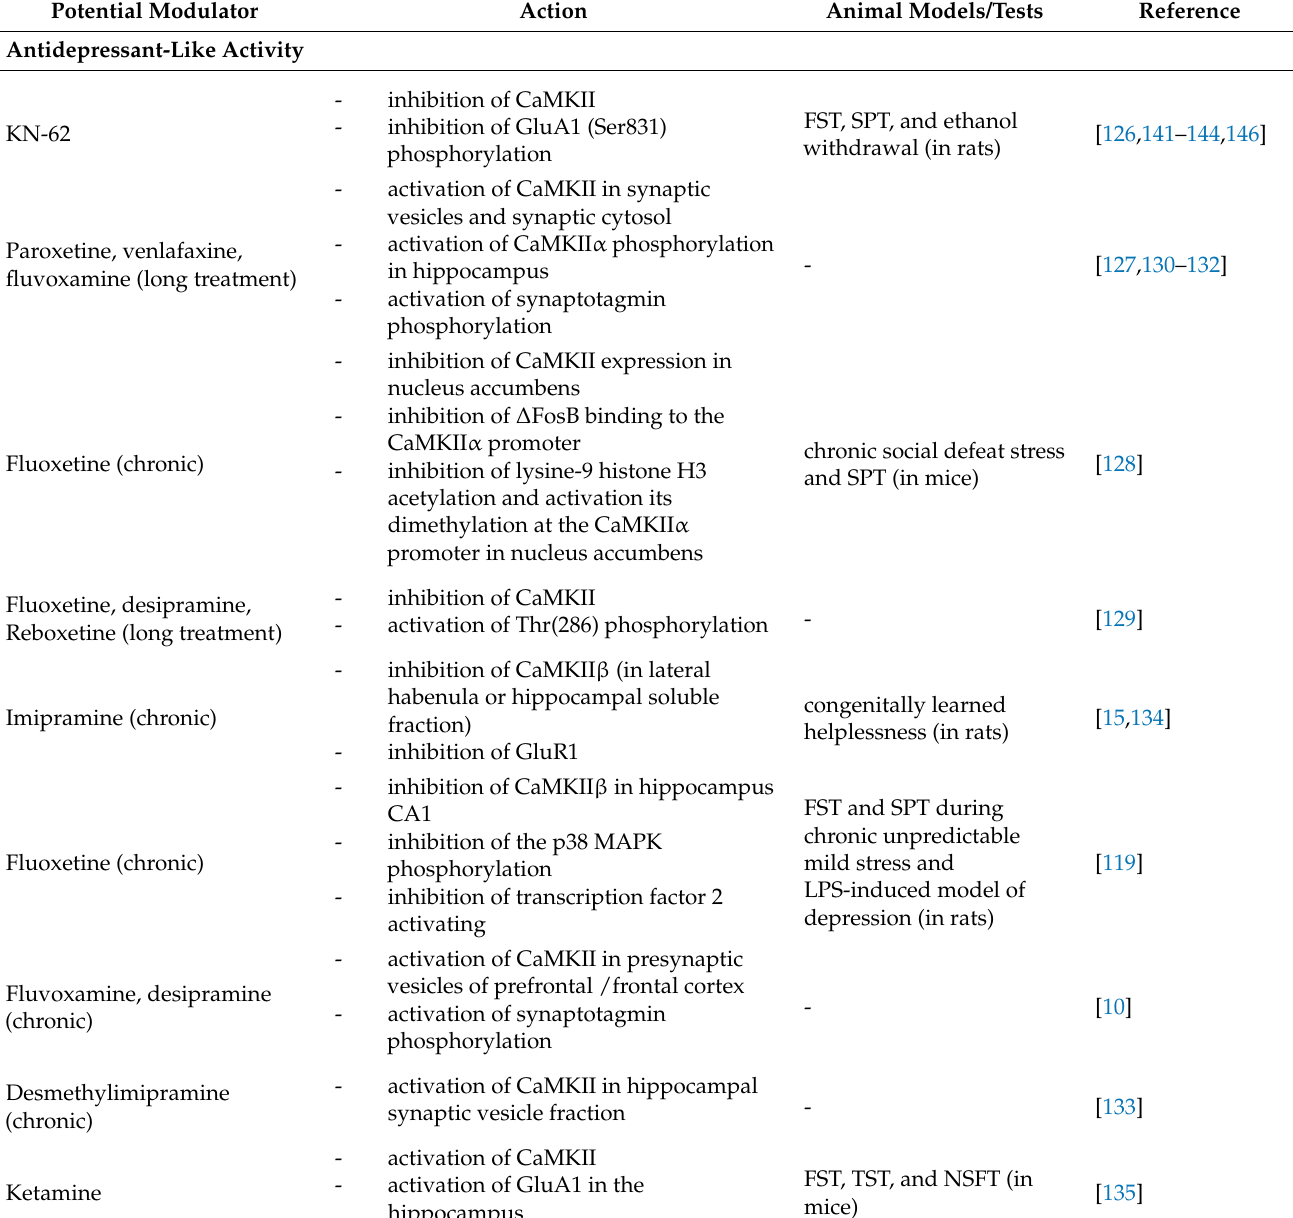
Table 3. Potential modulators of CaMKII and/or CaMKIV and their activity in animal tests/models of neuropsychiatric and neurodegenerative